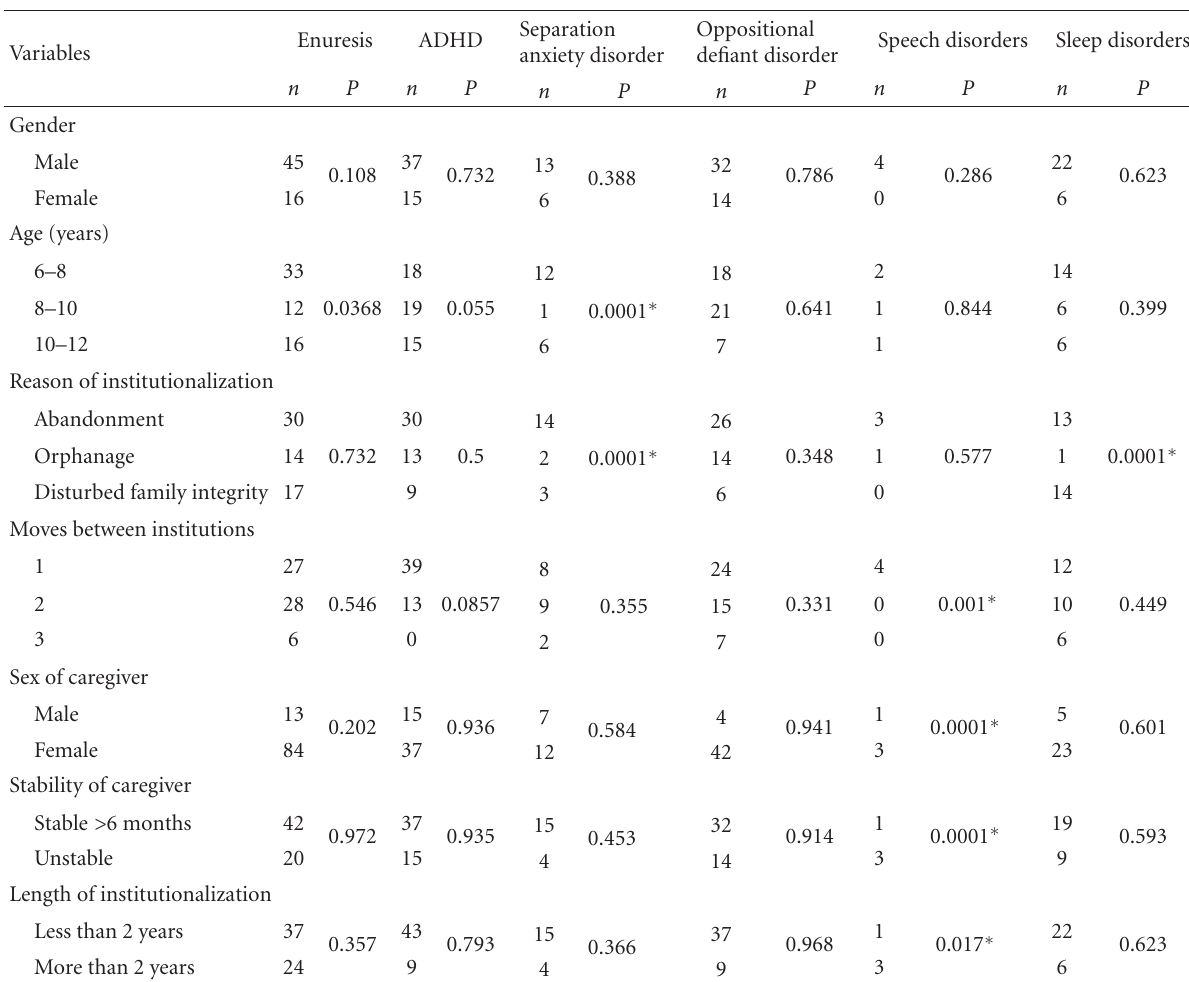
Table 5: (a) Psychiatric diagnoses of the orphans in relation to variables. (b) Psychiatric diagnoses of the orphans in relation to variables.